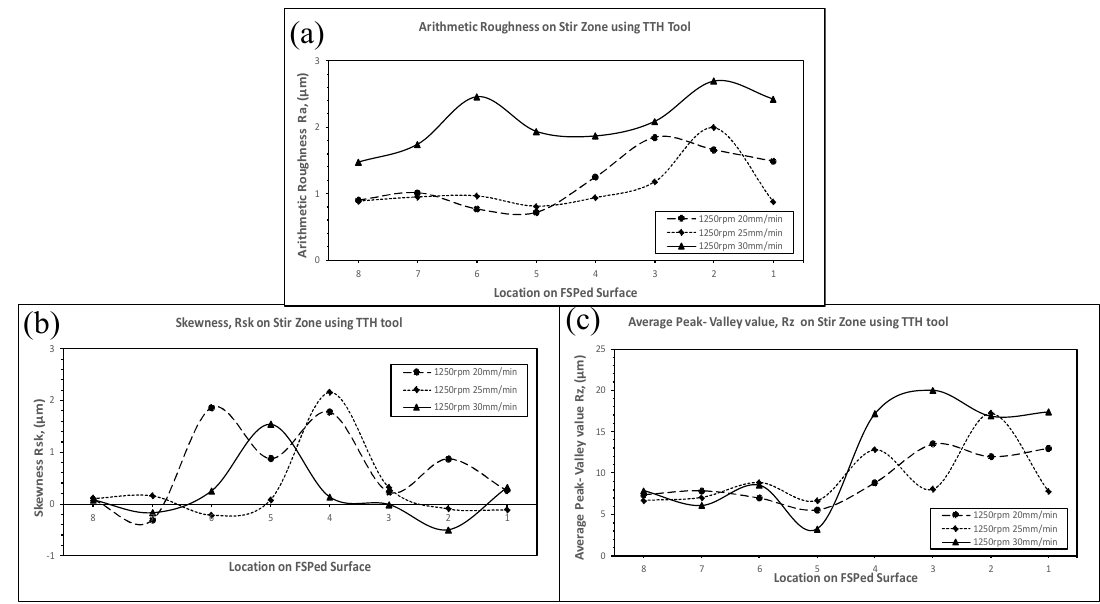
Figure 11. ( a ) Arithmetic roughness, Ra, ( b ) skewness, Rsk, and ( c ) average peak-valley, Rz, value for FSP using 1250 rpm and TTH tool at different feed rates.